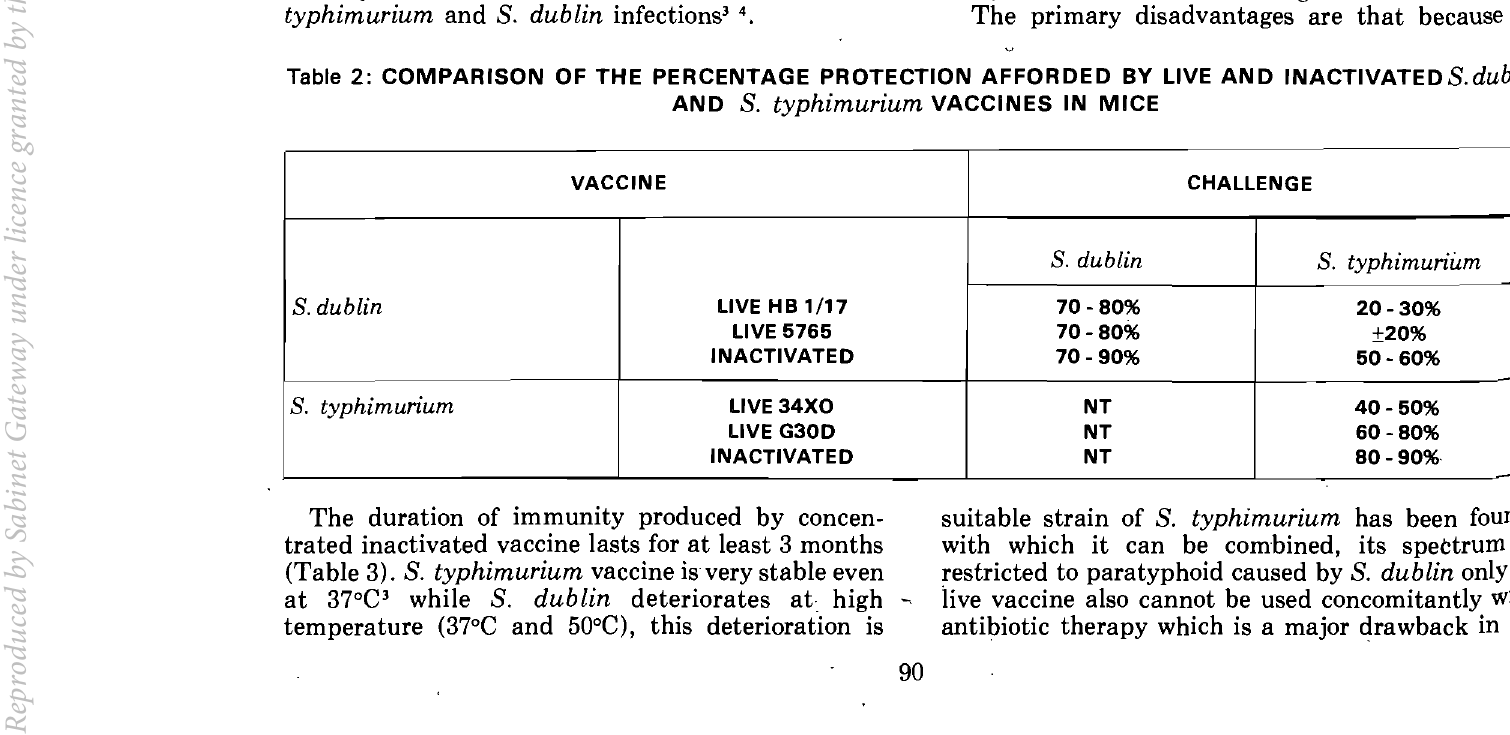
Table 2: COMPARISON OF THE PERCENTAGE PROTECTION AFFORDED BY LIVE AND INACTIVATEDS.dublin AND S. typhimurium VACCINES IN